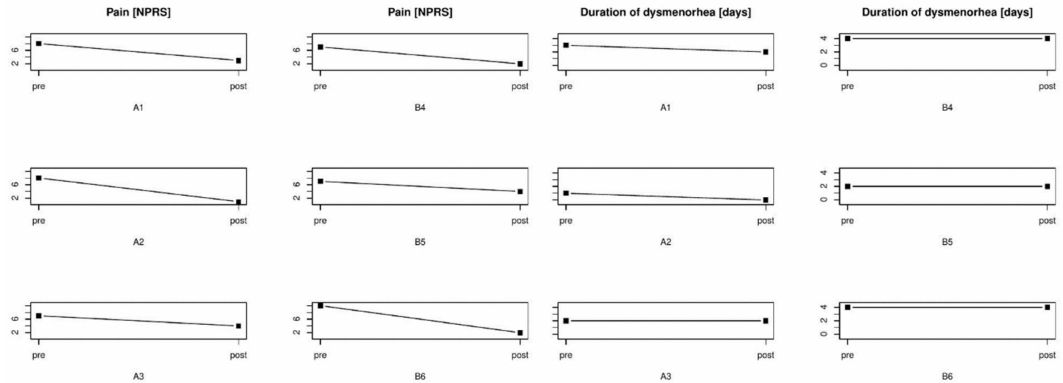
Figure 6. Intensity of pain in NPRS and duration of dysmenorrhea before and after manual therapy and taking ibuprofen. Abbreviations: A1, A2, A3, B1, B2, B3—patient designation, NPRS—Numeric Pain Rating Scale, Pre—result before treatment, Post—result after treatment. Table 2. Duration of menstrual cycle and duration of menstruation in patients in subgroups A and B. Patient